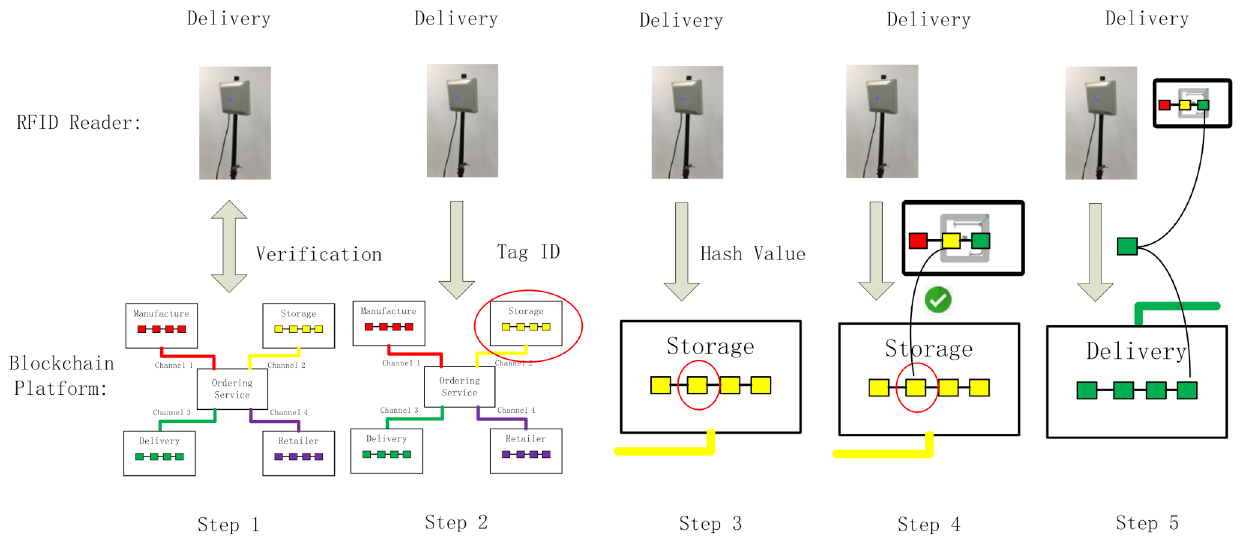
Figure 9. Workflow of the communication between the RFID reader and blockchain platform (The color is used to distinguish the blocks from different sessions in the supply